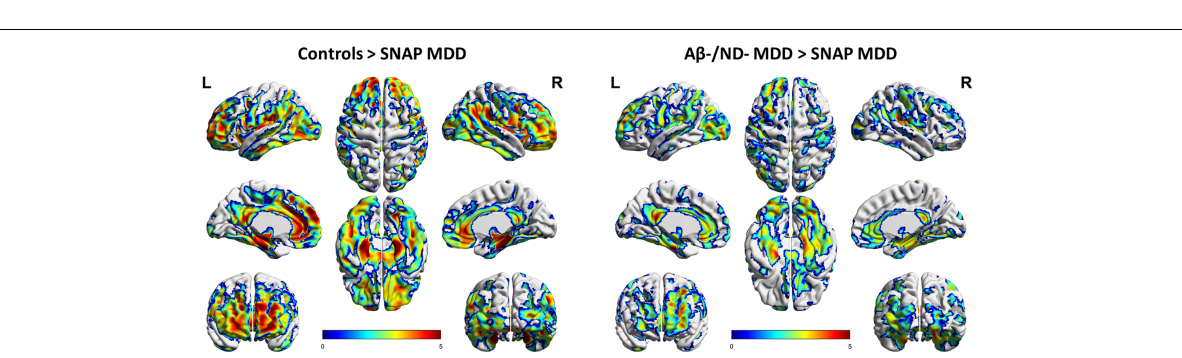
FIGURE 1 | Regions of interest comparisons of 18 F-florbetapir SUVRs in the SNAP ( n = 23) and A β –/ND– MDD ( n = 23) patients and controls ( n = 22) using data of partial volume correction (PVC). ∗ p < 0.05, ∗∗ p < 0.01, ∗∗∗ p < 0.001, ∗∗∗∗ p < 0.0001 using the Kruskal-Wallis test with Dunn’s post hoc analysis.